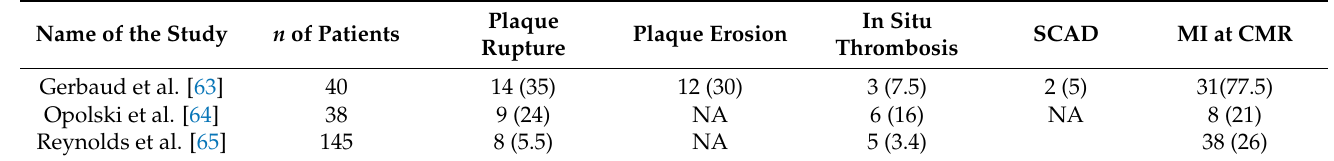
Table 1. OCT and CMR findings. SCAD: Spontaneous coronary artery dissection. MI: Myocardial